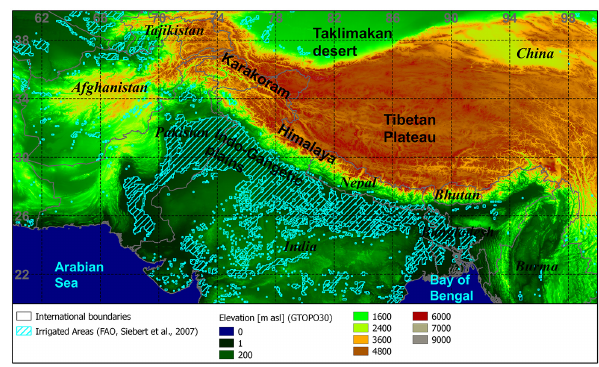
Figure 1. Geographic context of the study area (Himalayan arc and adjacent plains) including elevation and areas with >33% un- der irrigation (hatched). Data sources include the United Nations Food and Agriculture Organization (FAO) and the United States Geological Survey Global 30Arc-Second Digital Elevation Model